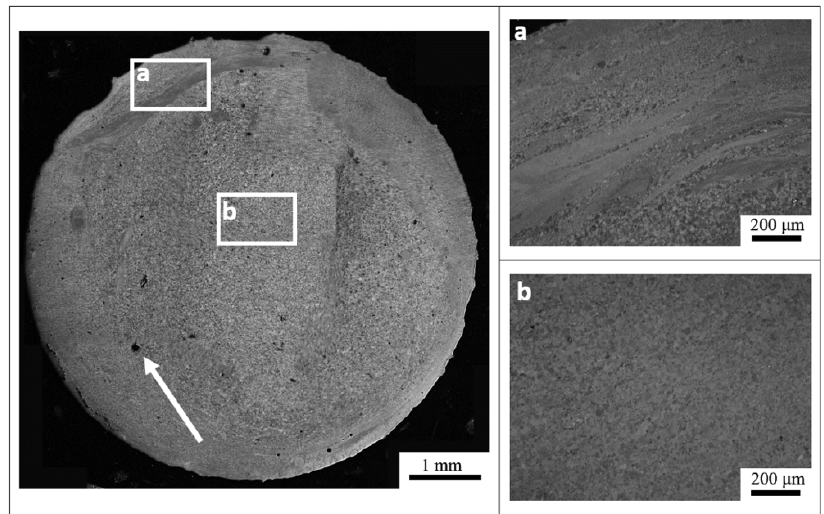
Figure 9. Polarised light micrograph of as-extruded wire from Ti-6Al-4V GA powder. ( a ) Shows the distinct layered structure around the outside of the wire. ( b ) A more uniform microstructure in the inner core of the wire. The arrow denotes an example of the porosity in this sample.